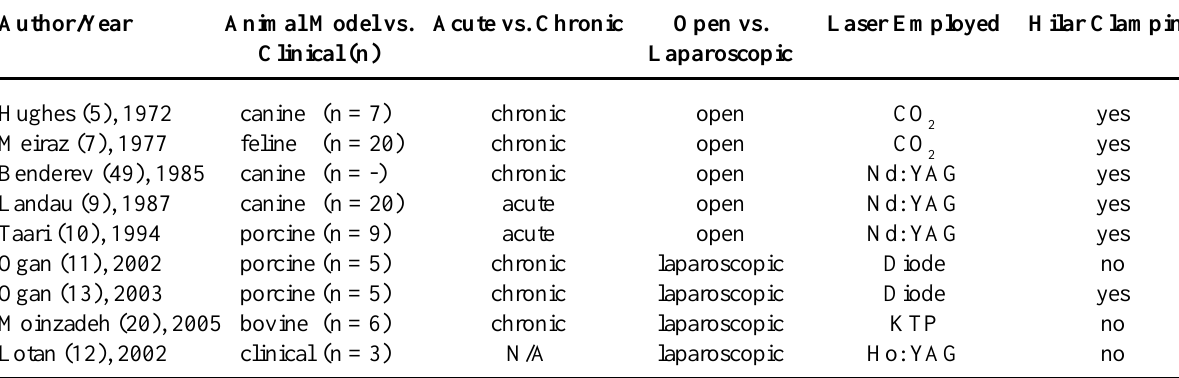
Table 1 – Use of laser during laparoscopic partial